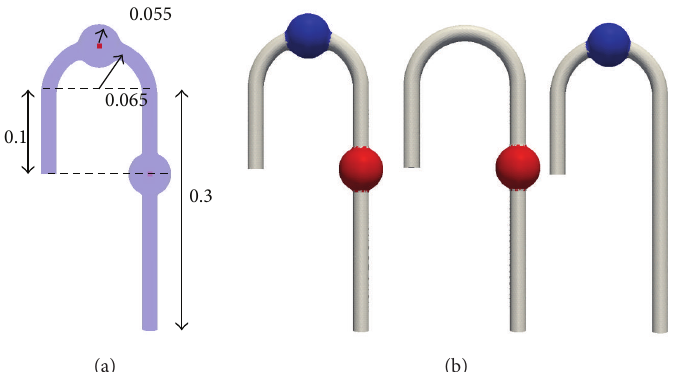
Figure1:DAA(left),TAAcured(centre),andAAAcured(right)geometries,red:abdominalaorticaneurysm,blue:thoracicaorticaneurysm. Inlet: left, outlet: right, all dimensions in meter.